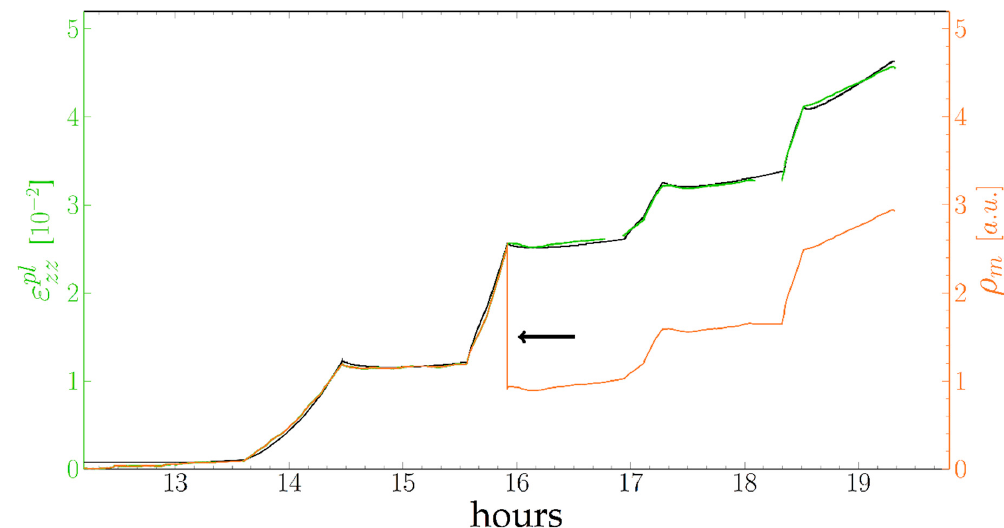
Figure 11. Plastic strain measured (green) and calculated (black) and dislocation density (orange). Arrow: drop of the dislocation density at 15 h 55.